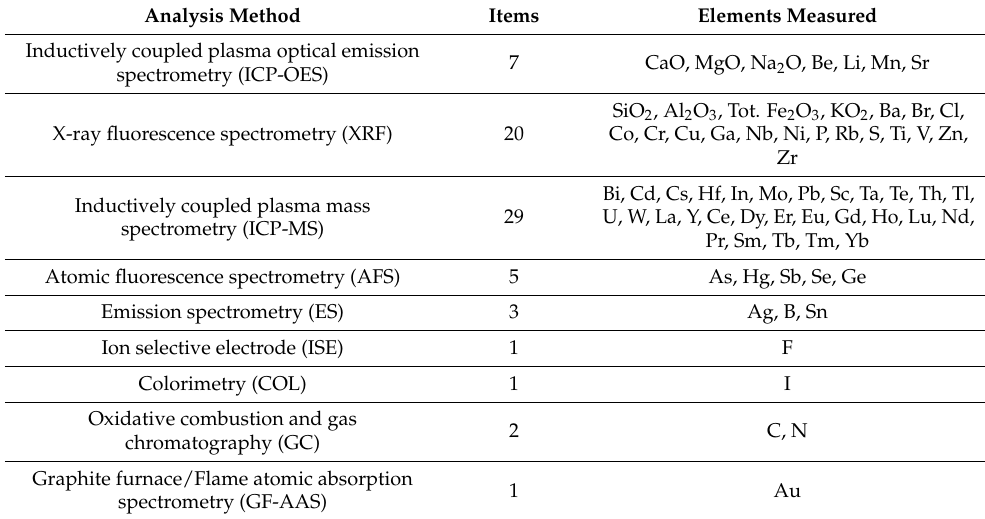
Table 1. Analysis methods used for the NGMPL.